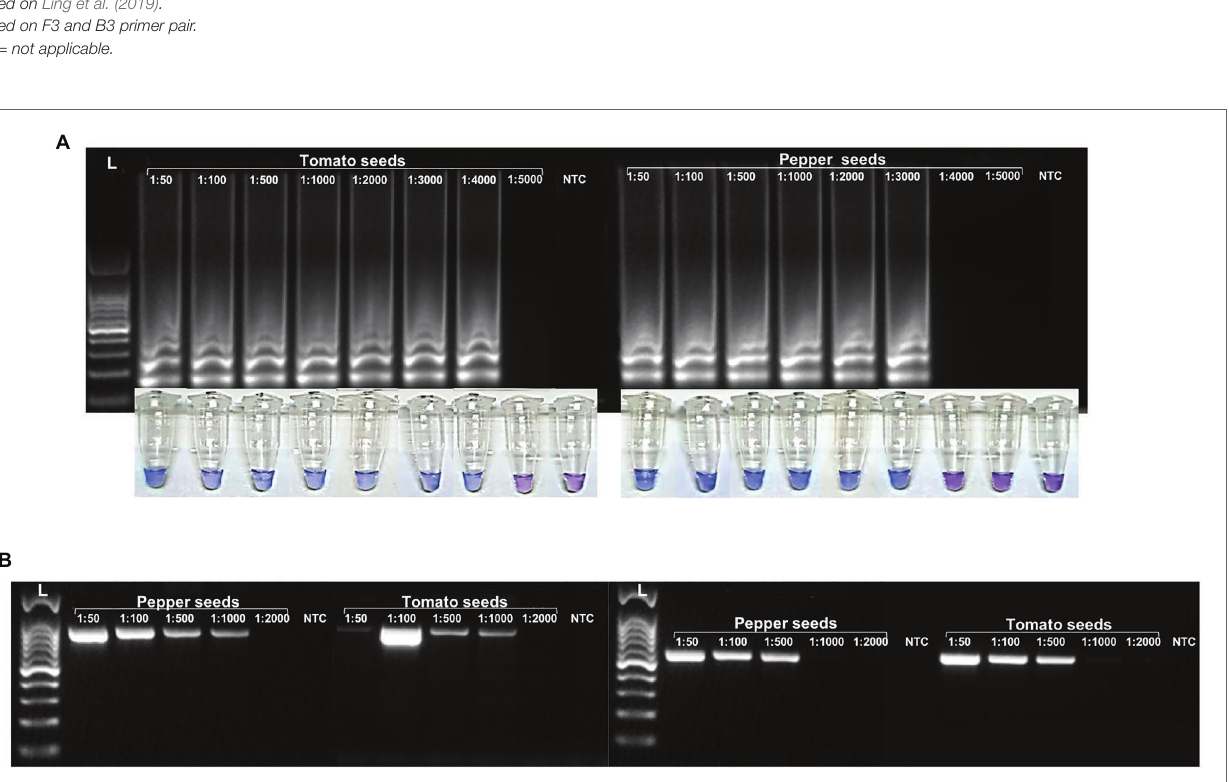
Mean Cq ± SD of seed-lots of tomato = mean of the three threshold cycles of each dilution (Cq) ± standard deviation (SD). Cq values above 30 were considered as negative results. 1 Based on Alkowni et al. (2019).